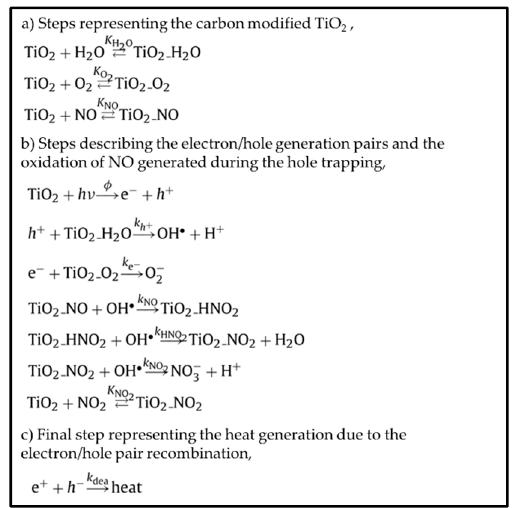
Figure 14. Reaction mechanism for the photodegradation of NO [116].